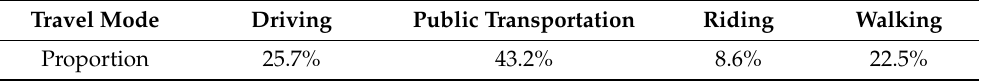
Table 1. Travel modes.